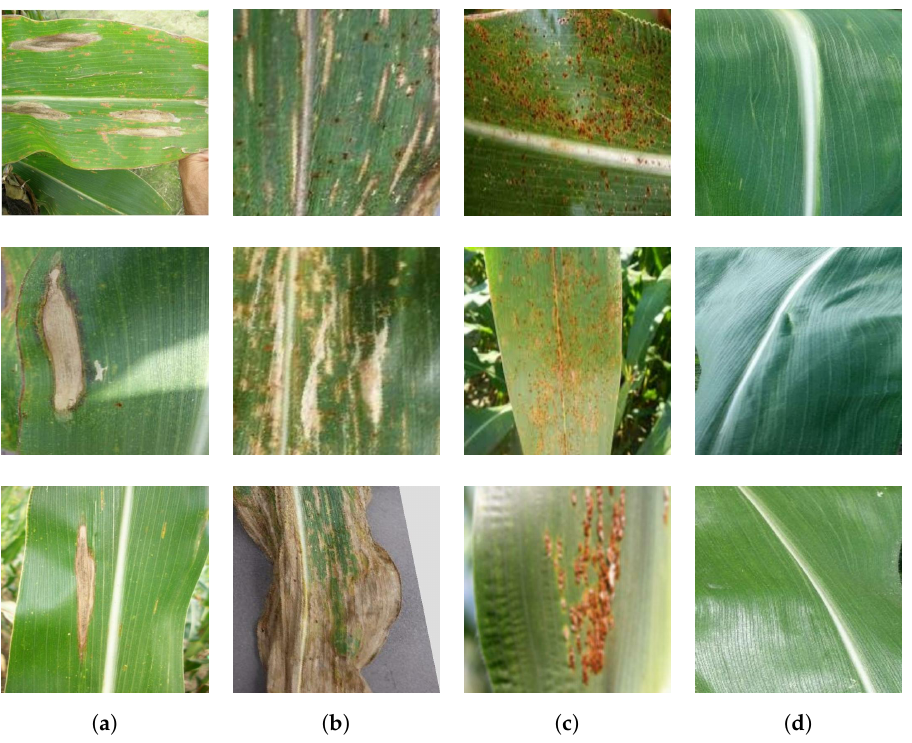
Figure 4. Example of maize leaf images from the PlantVillage dataset. The dataset contains the following classes: ( a ) Northern Corn Leaf Blight Exserohilum turcicum , ( b ) Gray Leaf Spot Cercospora zeae-maydis , ( c ) Common Corn Rust Puccinia sorghi and ( d ) healthy maize